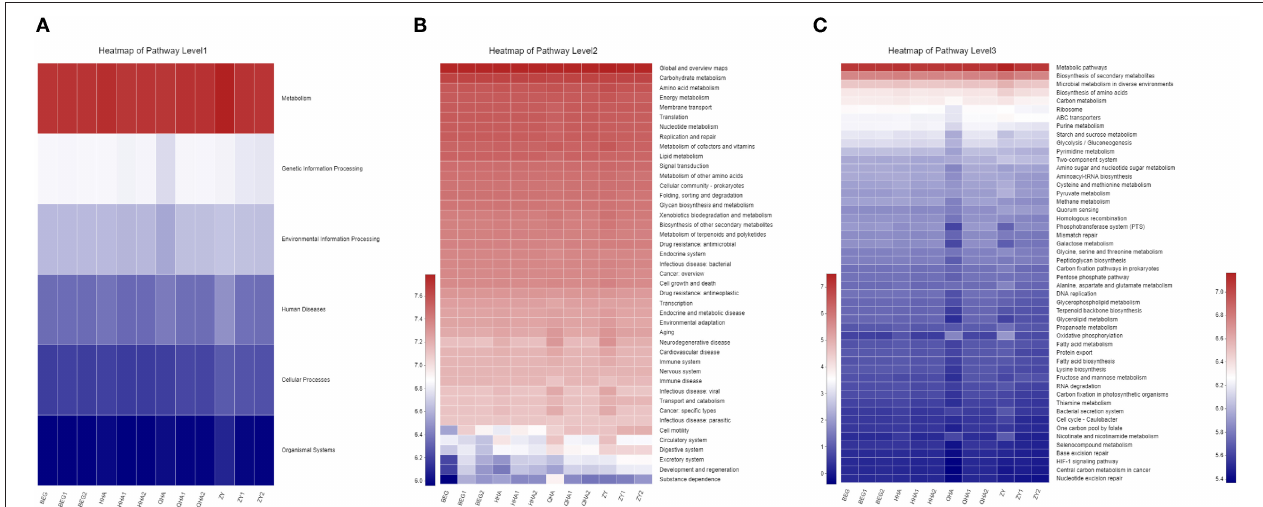
FIGURE 6 | Prediction of the bacterial community in different koumiss samples. (A) Overall KEGG gene function statistics (Level 1). (B) The heatmap of functional pathways (Level 2). (C) The heatmap of functional pathways (Level